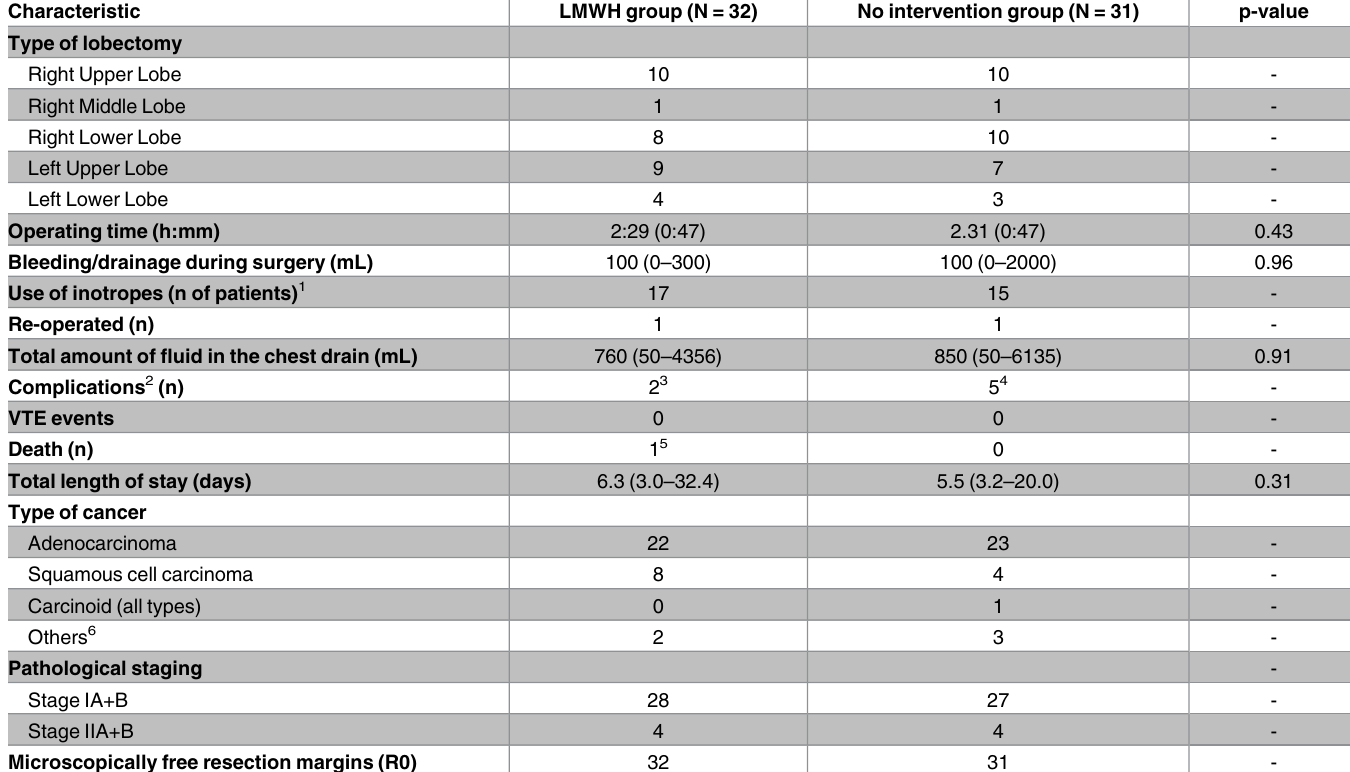
Table 2. Peri- and postoperative data from 63 patients planned for Video-Assisted Thoracoscopic Surgery (VATS) lobectomy for primary lung cancer.